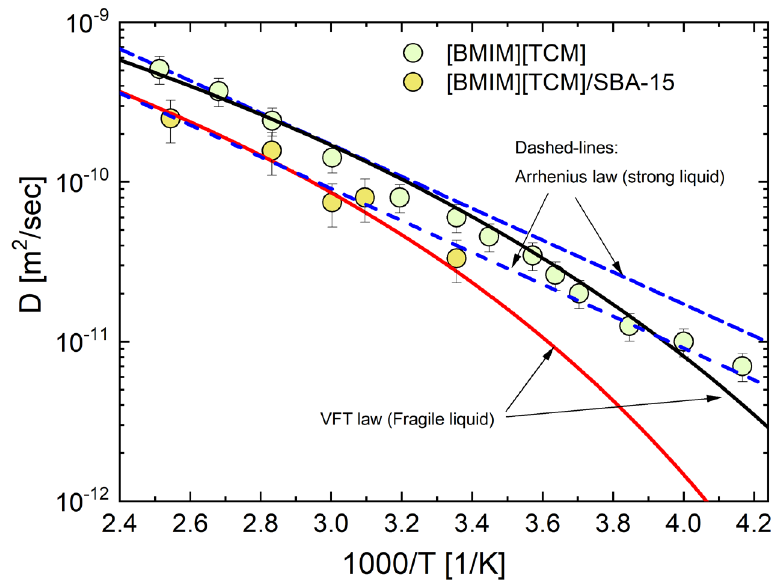
Figure 5. Self - diffusion coefficients D as a function of the inverse temperature obtained from 1 H NMR measurements for the bulk ionic liquid and confined [BMIM] + [TCM] − ionic liquid in SBA - 15. The black and red lines are the fit curves obtained using the VFT law. The dashed lines are the relevant Arrhenius curves.